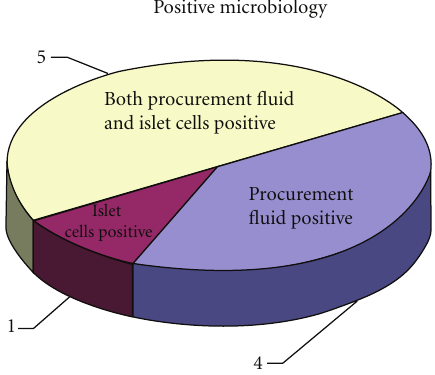
Figure 7: Number of cases in which the pancreas procurement fluid and/or the islet cells showed positive